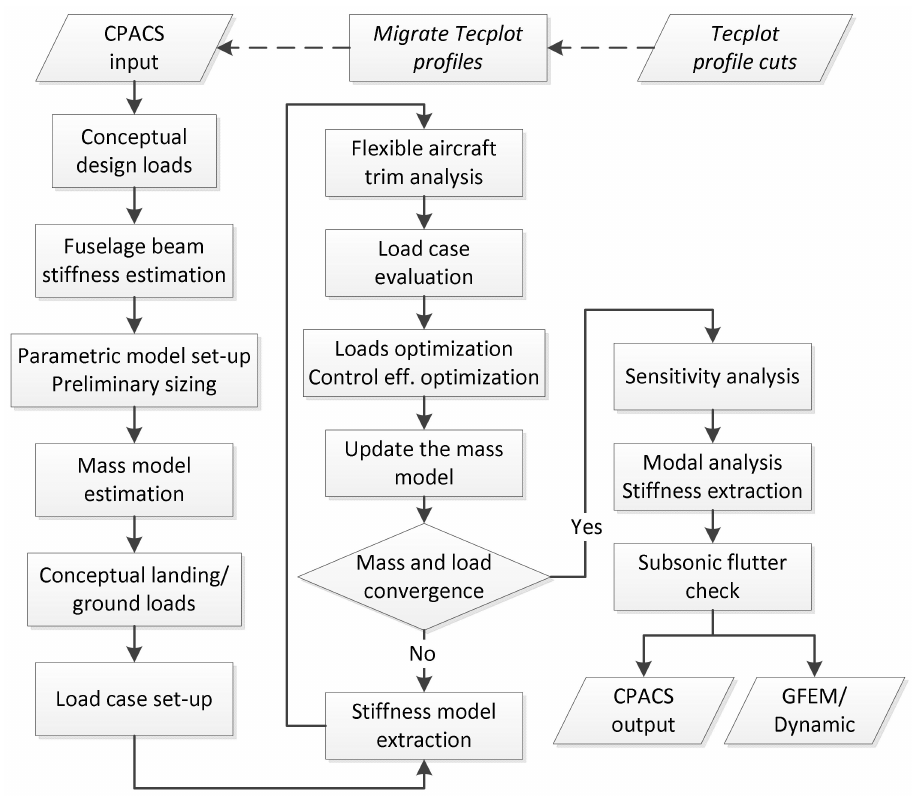
Figure 5. Process flow of cpacs-MONA.